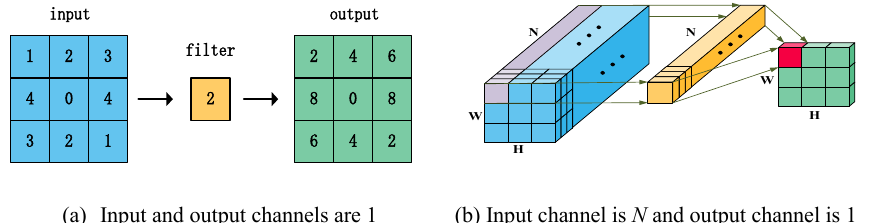
Fig. 5 Schematic diagram of convolution operation. 1 × 1 Figure 10. Working diagram of 1 × 1 convolution operation.